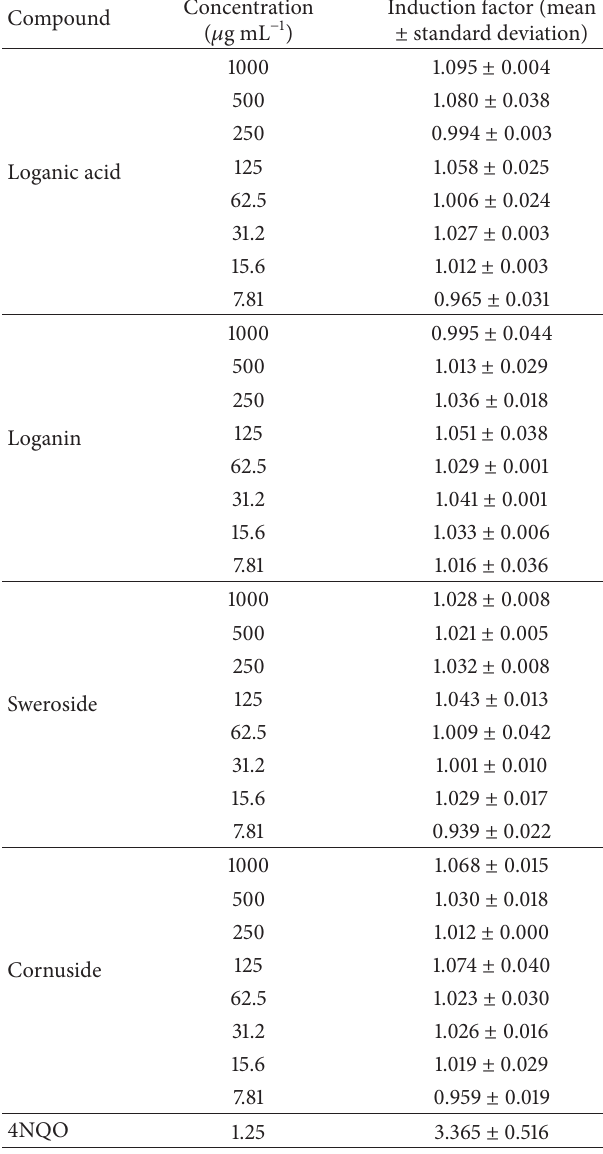
Table 2: Primary DNA damage assay in E. coli PQ37. Compound